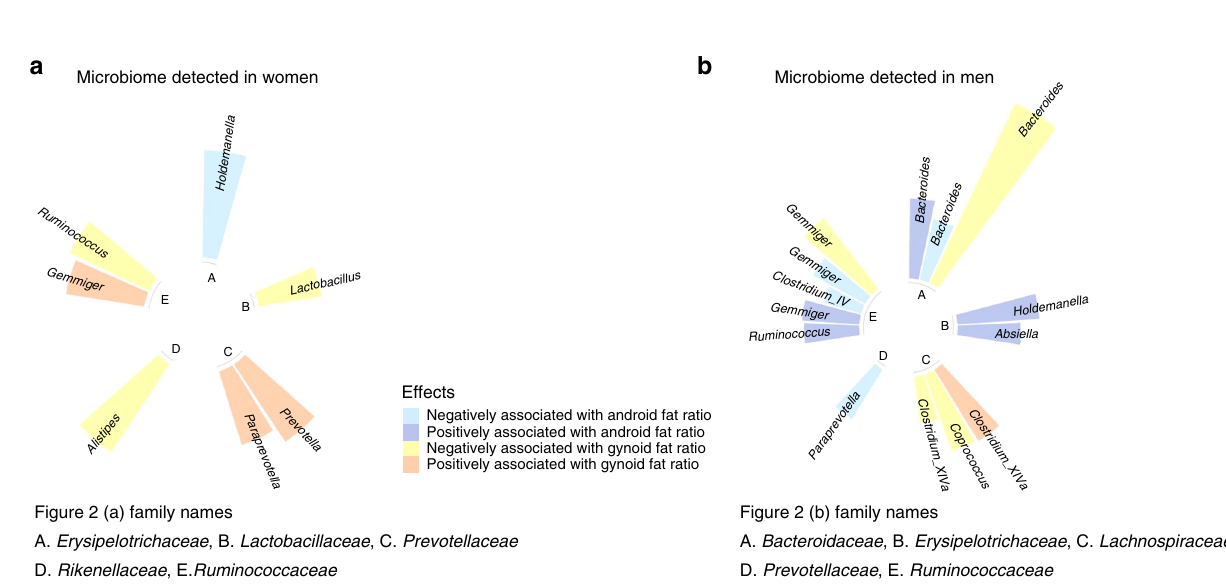
Fig. 2 Taxa associated with fat distribution in men and women. The fi gure summarizes four associations between microbiome abundance and fat distribution. The colors, from blue to red, encodes the following four effects, respectively: negative and positive associations with android fat ratio, negative and positive associations with gynoid fat ratio. The height of each bar indicates microbiome abundance on a log2 fold change scale. The inner circular segments separate microbial taxa by their family names. Panel a shows the four effects among female samples and panel b shows the effects in male